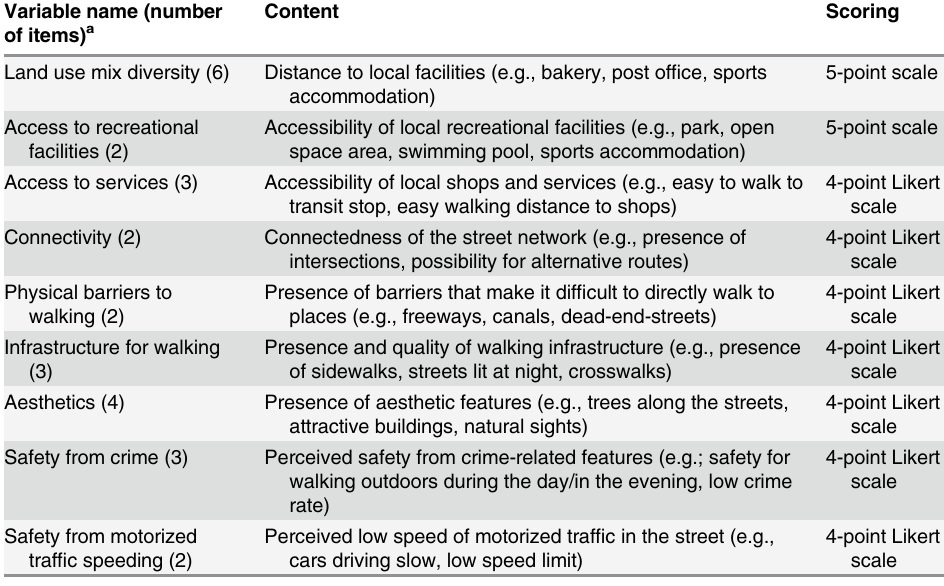
Table 1. Content and scoring of the perceived environment